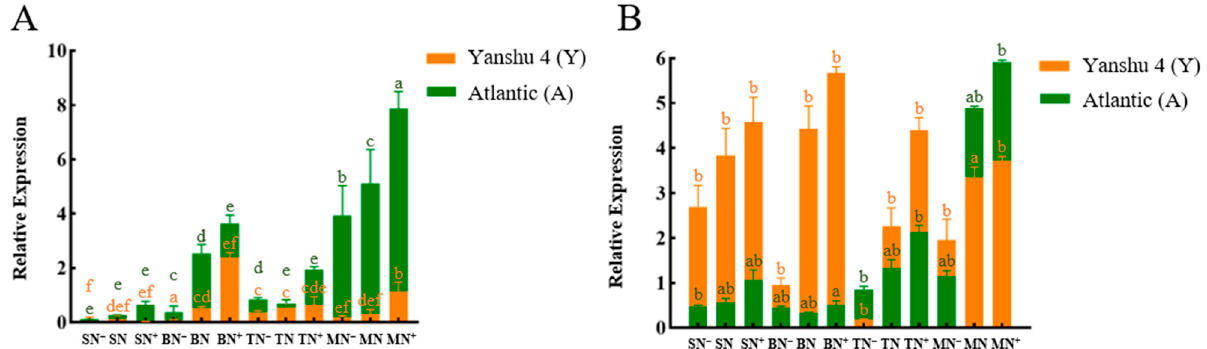
Figure 2. Relative expression of nitrite reductase gene StNiR in two genotypes of potato under different N supply levels. ( A ) Leaf (L); ( B ) Root (R). S, B, T, and M represent seedling stage, budding stage, tuber expansion stage, and mature stage, respectively. N − , N, N + are different N supply levels, representing low N, normal N, and excess N, respectively. Different letters indicate the difference of relative gene expression in different periods under different N application levels ( p < 0.05).